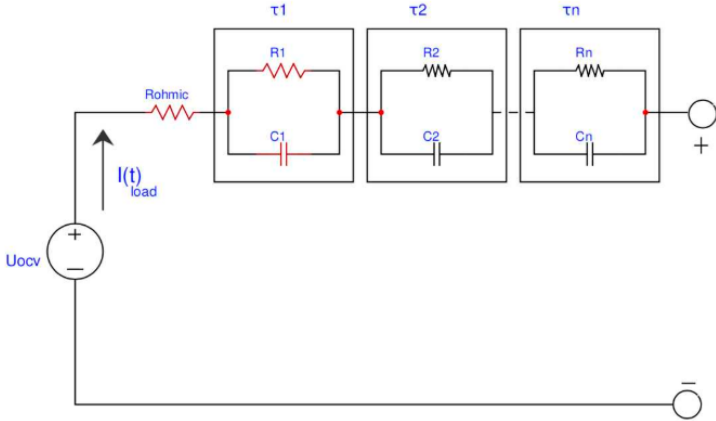
Figure 3. Equivalent circuit model used in describing the voltage response of Li-ion batteries.